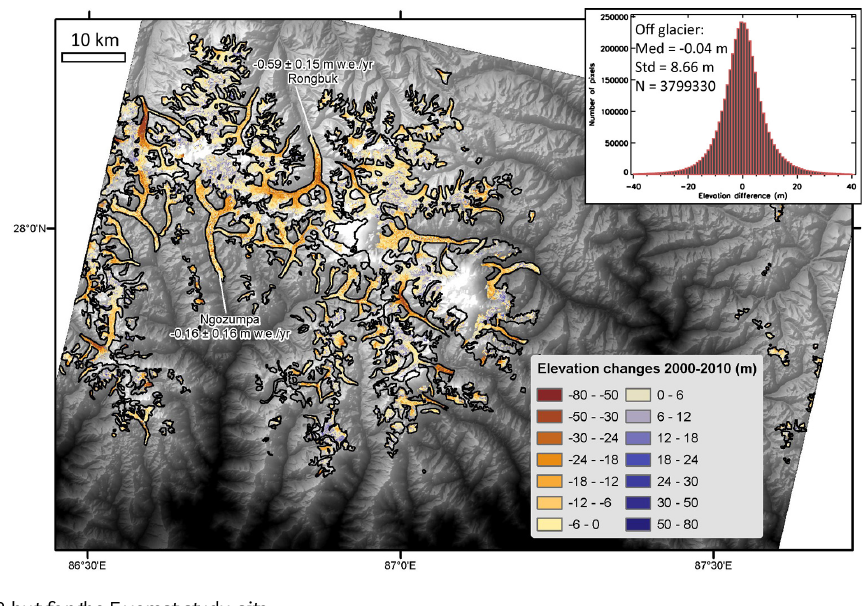
Fig. 4. Same as Fig. 2 but for the Everest study site.